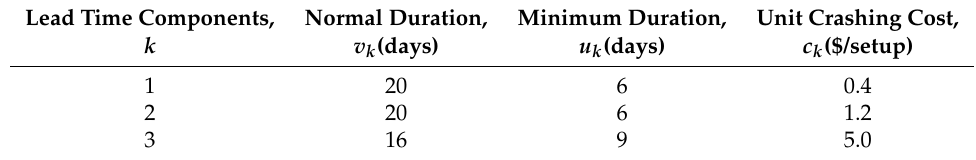
Table 2. Data for lead time.